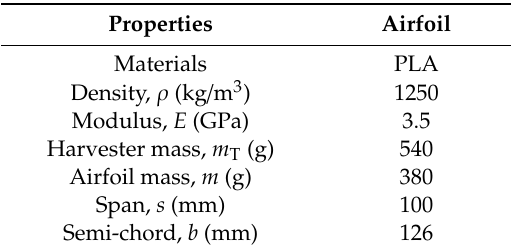
Table 2. Airfoil dimensional parameters.